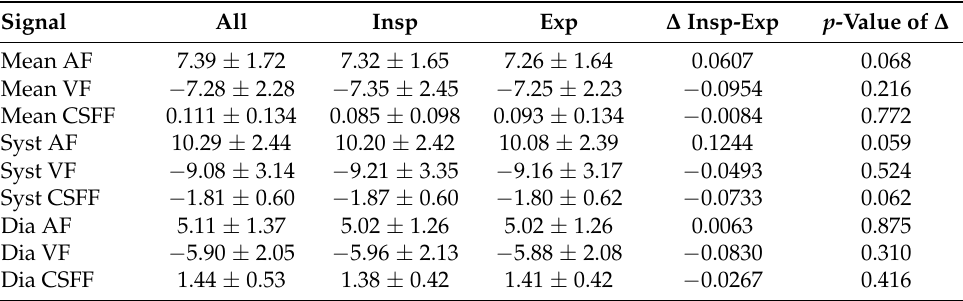
Table 2. Mean amplitudes in median pulse waves [mL/s]. Legend: AF = arterial flow; VF = venous flow; CSFF = cerebrospinal fluid flow; Syst = systolic; Dia = diastolic; Insp = inspiration; Exp = expiration; Insp =